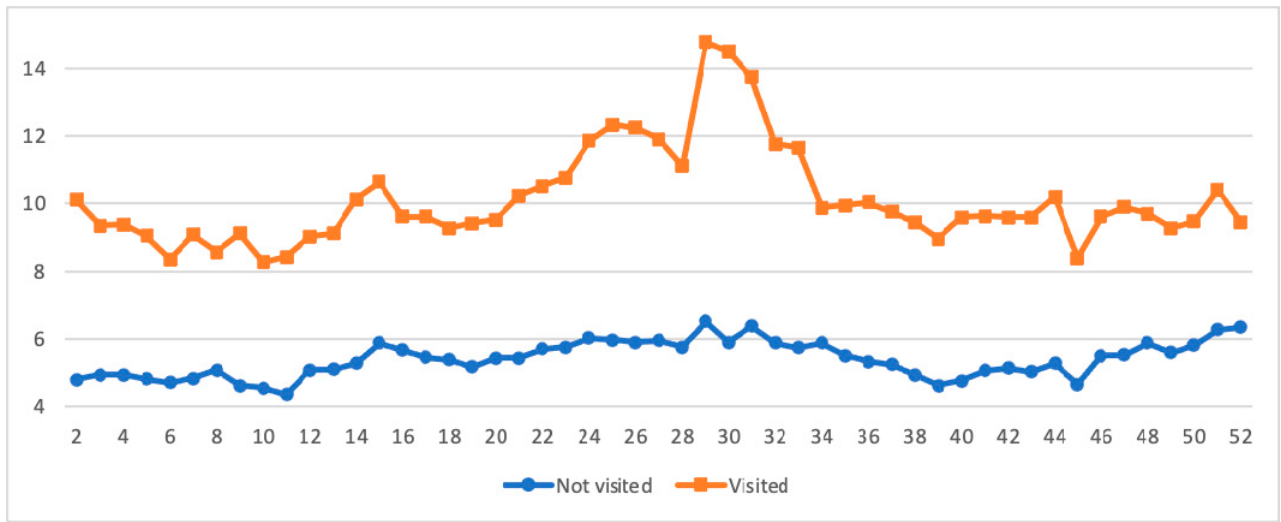
Figure 3. Weekly negative emotion levels in posts/comments by subreddit.